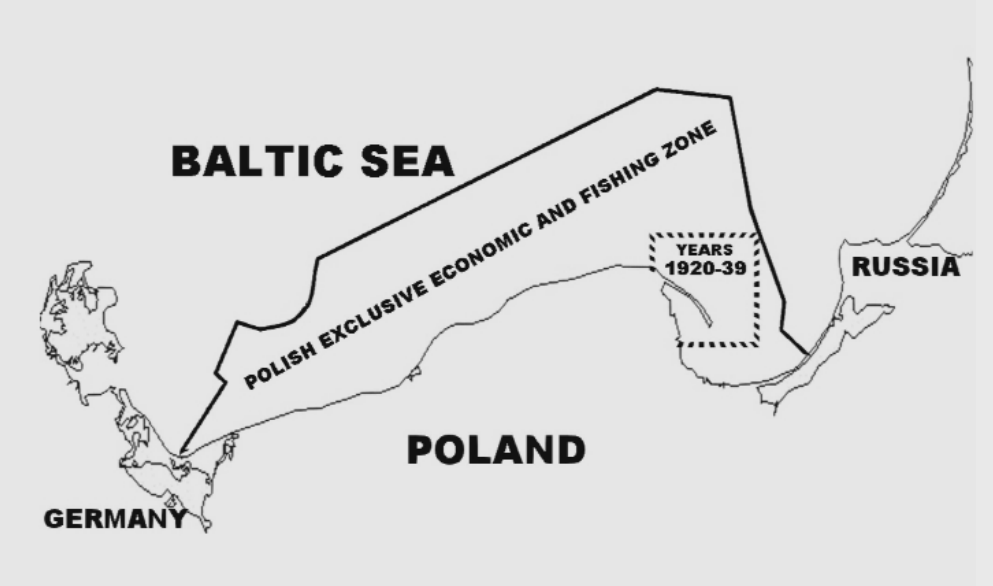
Fig. 5. Polish mar- itime areas in the years 1920-1939 (dashed line) and at present (solid